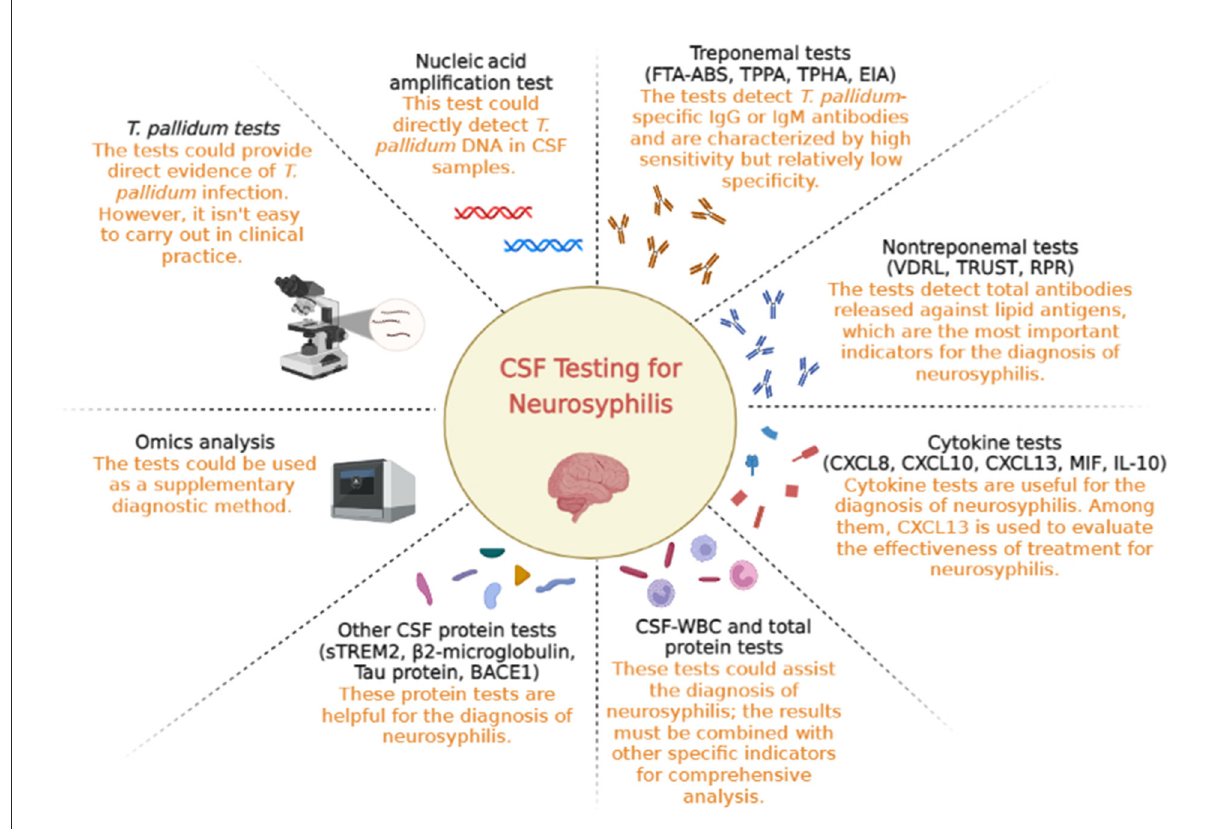
FIGURE1 Overview of cerebrospinal fluid testing for